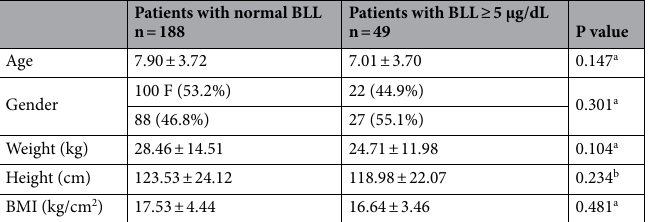
Patients with BLL ≥ 5 µg/dL n = 49